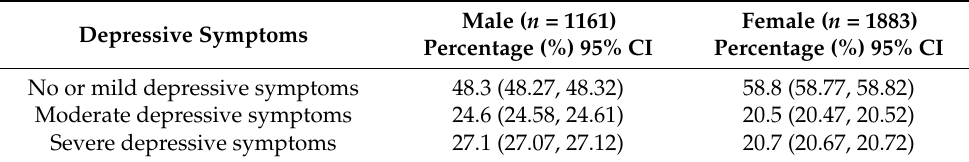
Table 2. Prevalence of depressive symptoms by